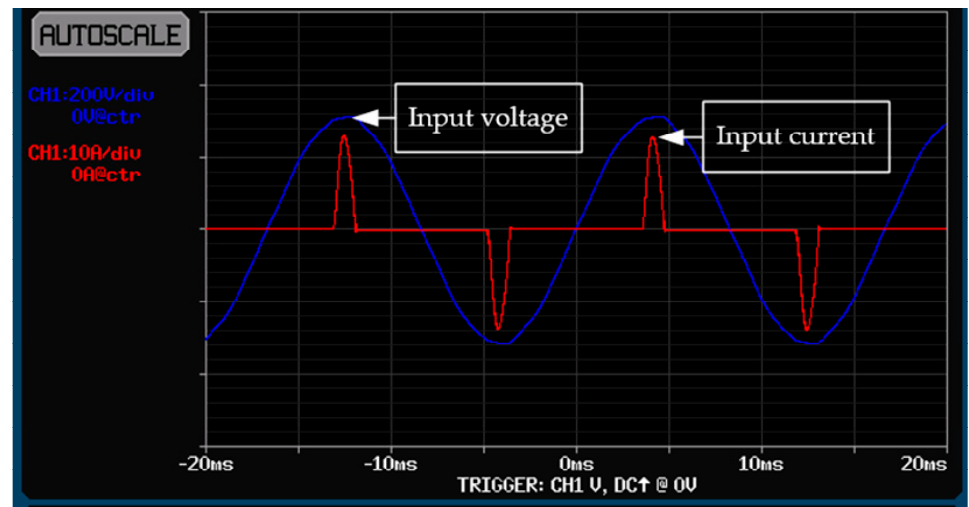
Figure 16. Input voltage and input current waveforms of the commercially available drive.